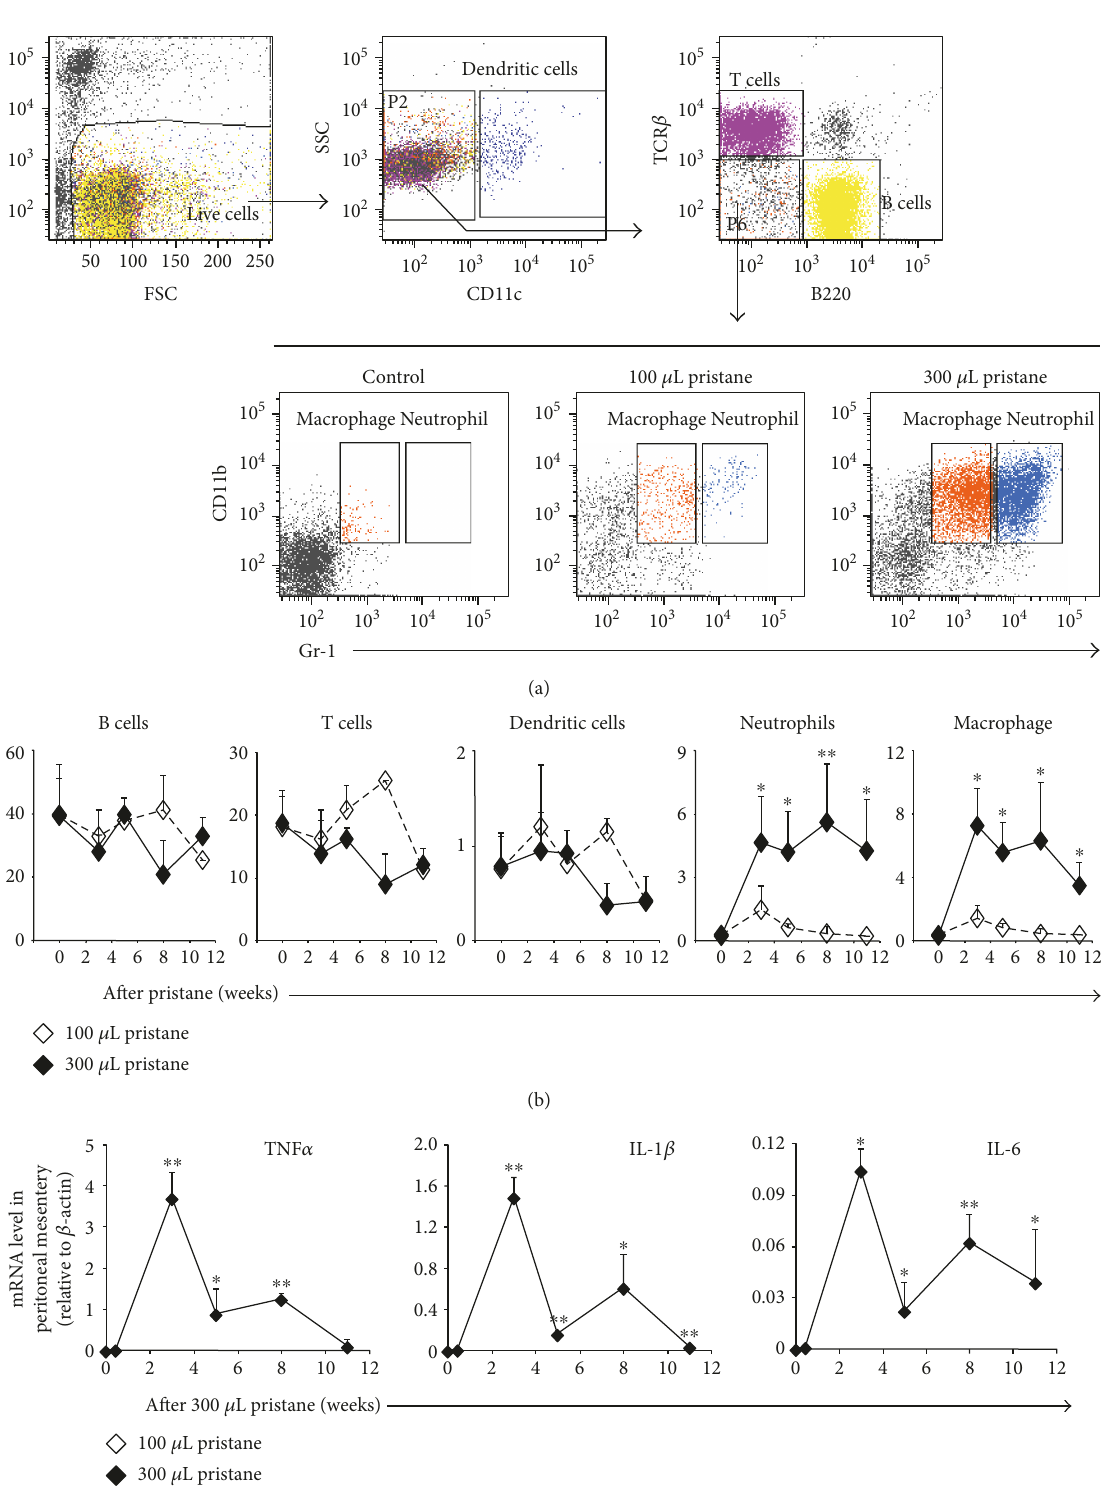
Figure 1: Leukocyte responses to pristane treatment were dose dependent. Whole splenic cells were analyzed using fl ow cytometry after staining with antibodies speci fi c for B220, TCR β , CD11c, CD11b, and Gr-1 (a). The number of B cells (B220 + ), T cells (TCR β + ), dendritic cells (CD11c + ), macrophages (CD11b + Gr1 low ), or neutrophils (CD11b + /Gr1 hi ) in the spleen was quanti fi ed (b). The di ff erence between 100 μ L of pristane treatment and 300 μ L of pristane treatment in C57BL/6J mice is shown. (c) Peritoneal mesentery was collected from C57BL/6 mice treated with 300 μ L of pristane and analyzed for the expression of cytokines. The di ff erence between 300 μ L pristane-treated and nontreated C57BL/6J mice is shown. Data represent two independent experiments. ∗ p < 0 05 and ∗∗ p < 0 01